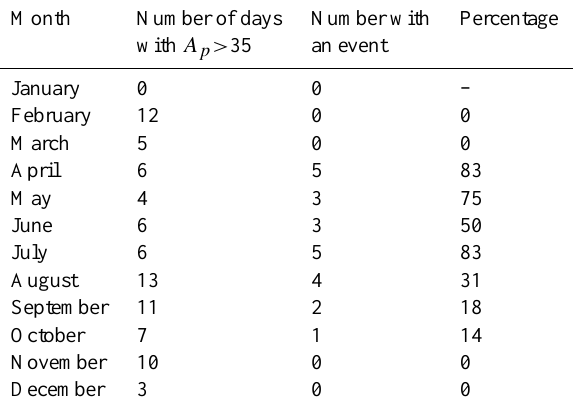
Table 2. Monthly statistics of event occurrence in the night sector when A p >